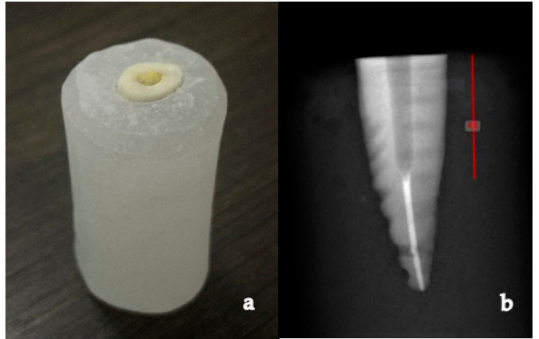
Figure 1. ( a ) Mounted specimen sectioned the cement-to-enamel junction; ( b ) Radiograph of opti- mally prepared post